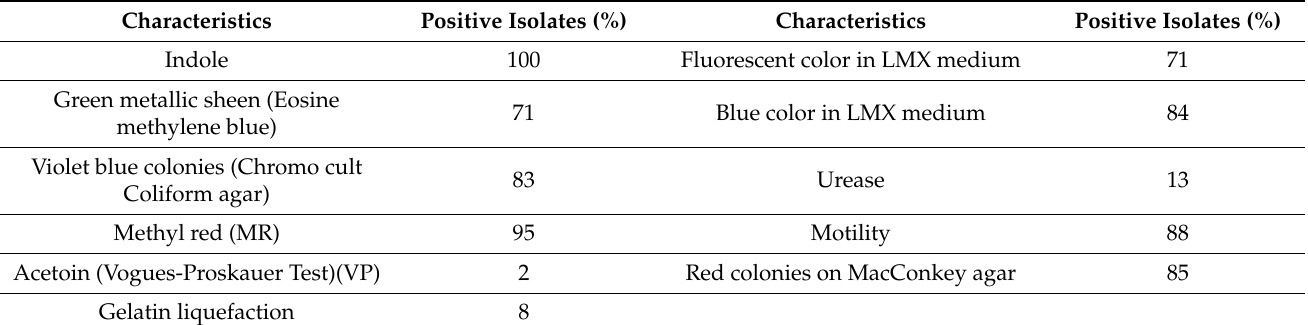
Table 1. Physiological properties of 48 isolates obtained from different regions for ice-cream. Characteristics Positive Isolates (%)